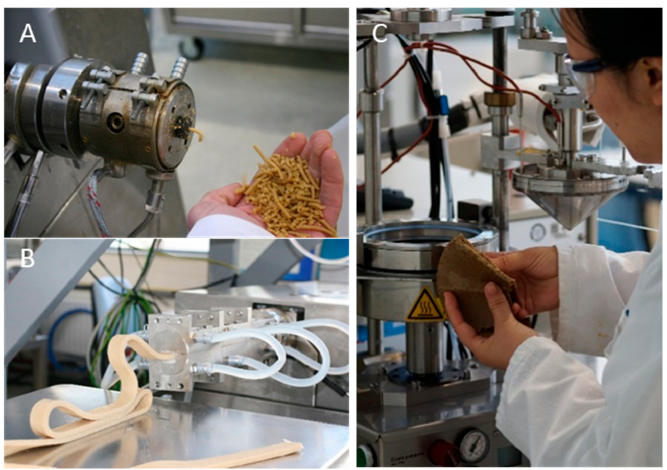
Figure 1. Technologies for plant protein texturization: ( A ) low moisture extrusion, ( B ) high mois- ture extrusion and ( C ) shear cell technology. The person in figure has given the consent to use this